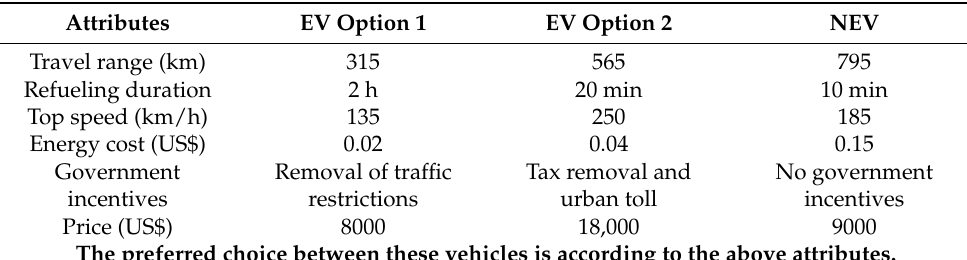
Table 5. Sample vehicles choice